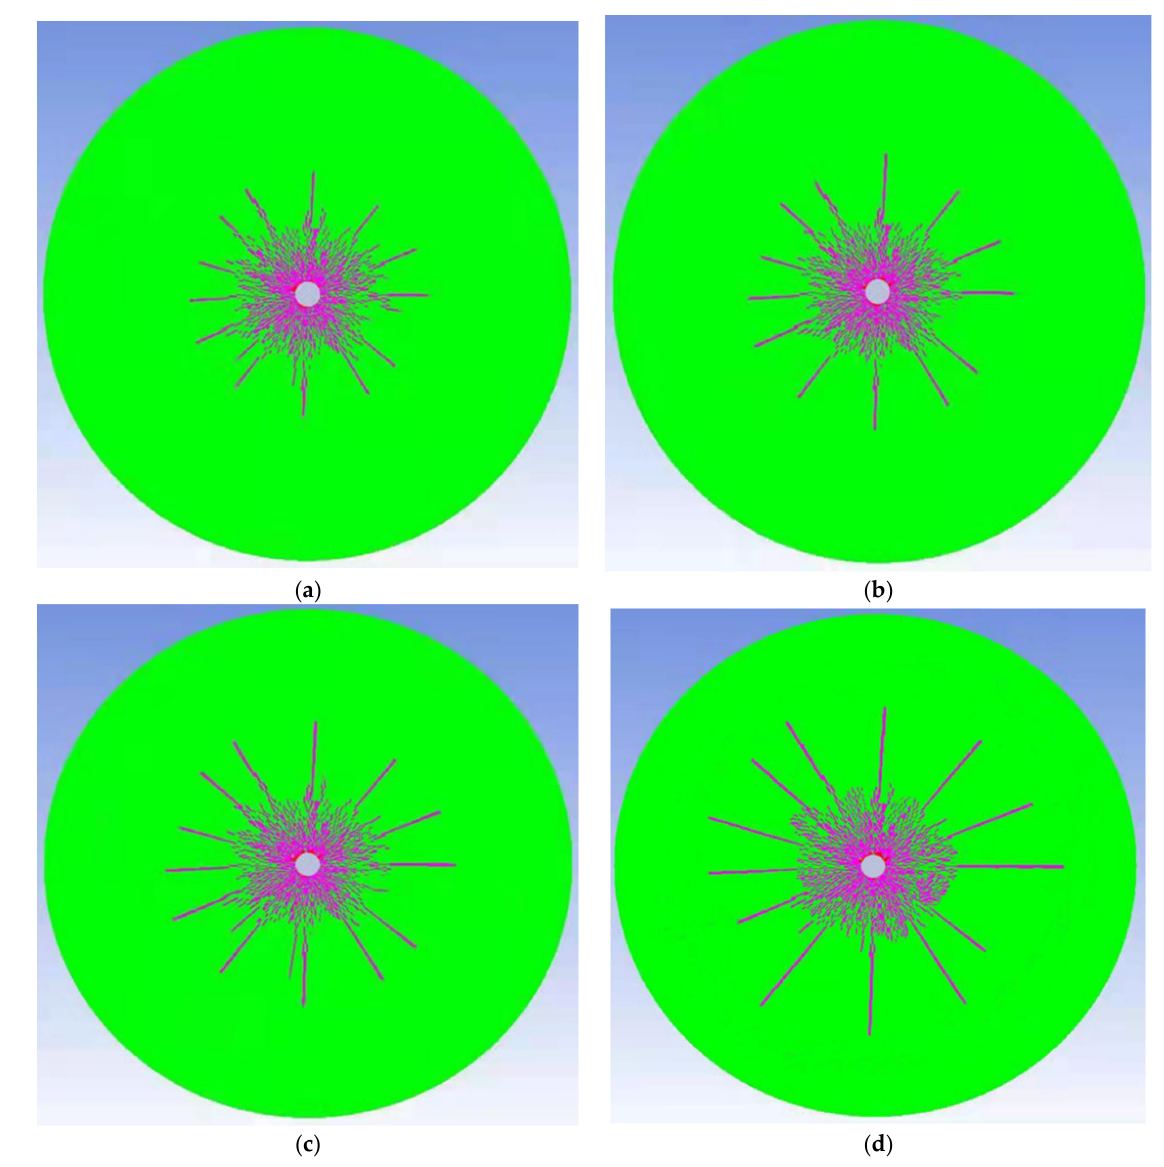
Figure 13. Damage and fracture characteristics of rock mass with different porosity under explosive dynamic load. ( a ) The porosity is 0.1%; ( b ) The porosity is 0.15%; ( c ) The porosity is 0.18%; ( d ) The porosity is 0.25%.